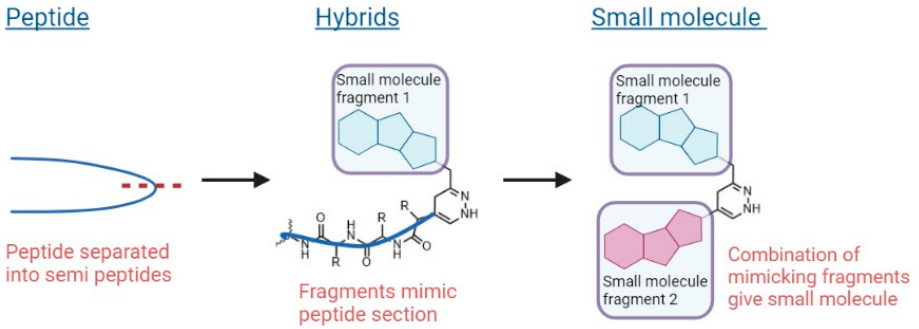
Figure 33. Peptide directed binding.